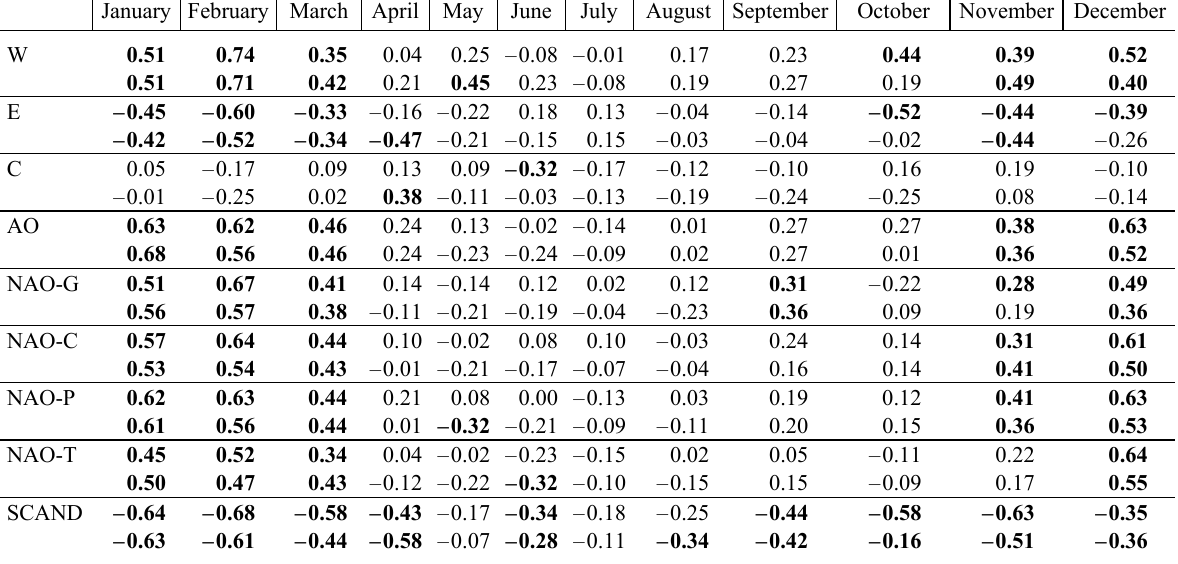
Table 4. Correlation coefficients between the monthly variables of atmospheric circulation (frequencies of circulation macro- forms W, E and C according to the Vangengeim(cid:150)Girs classification, Arctic oscillation (AO) index, North Atlantic oscillation (NAO) indices and Scandinavian (SCAND) teleconnection pattern) and monthly numbers of storm days at Vilsandi (upper values in the boxes) and Sırve (lower values) in 1966(cid:150)2011. Statistically significant correlations on the p < 0.05 level are typed in